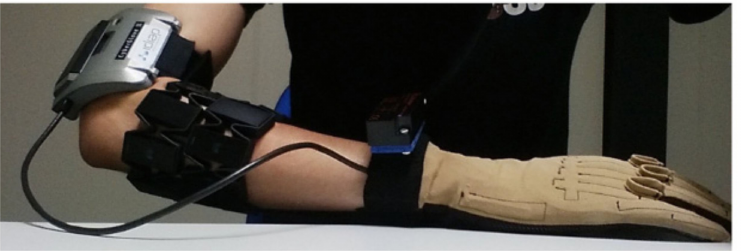
Figure 3. Myo armband and dataglove setup in data acquisition experiments [33] (Adapted with permission license CC BY 4.0 (2017)).